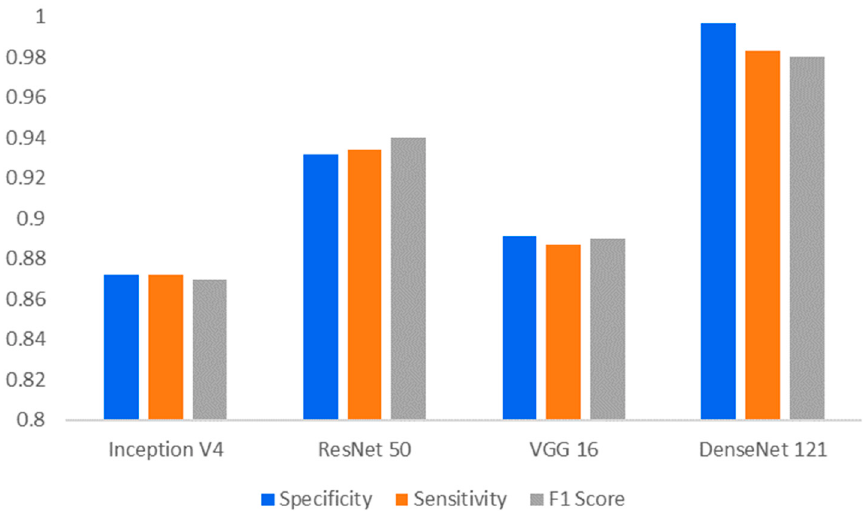
Figure 10. Performance analysis of pre-trained models based on different evaluation metrics.